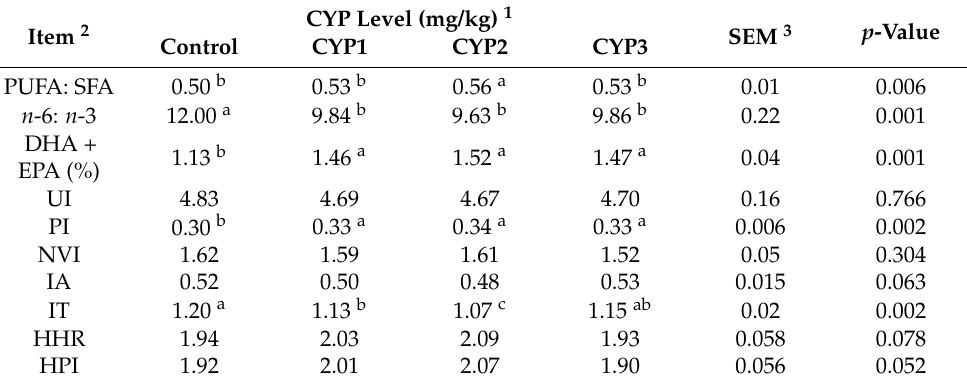
Table 6. Effects of CYP on fatty acid nutrition index in breast muscle of broilers. Item 2